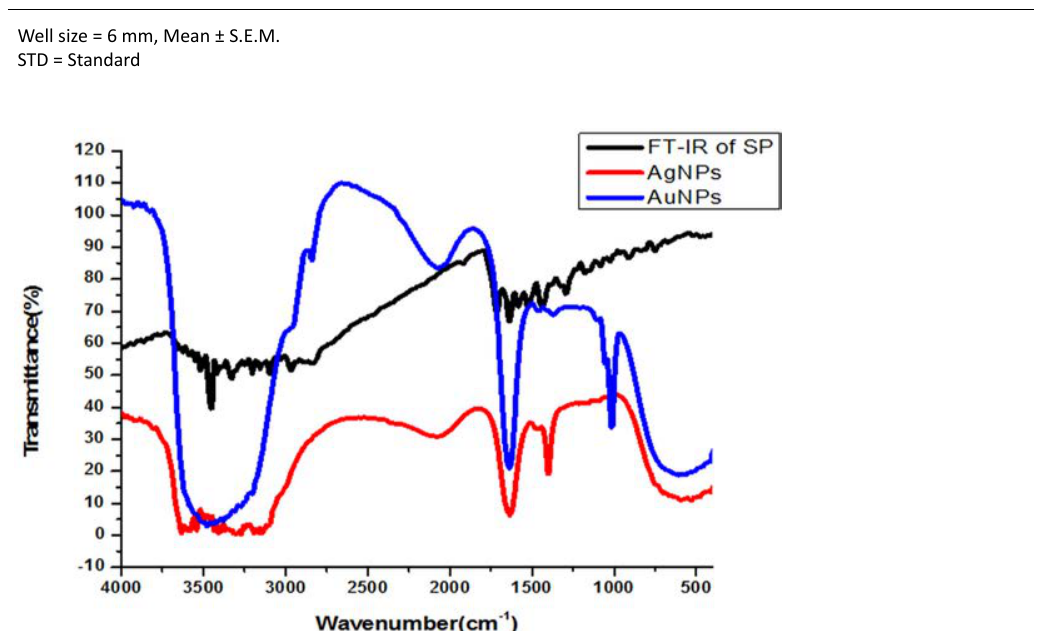
Table 1. Antibacterial activities of sparfloxacin and its noble metal (Ag/Au) NPs Bacterial strain Strain Sparfloxacin Ag-Sp NPs Au-Sp NPs Streptomycin ZOI (mm) at 3 mg/mL Staphylococcus aureus + 30±0.92 24±0.94 24±0.94 30±0.98 Bacillus subtilis + 30±0.94 22±0.79 22±0.79 30±0.98 - 32±0.92 20±0.98 26±0.92